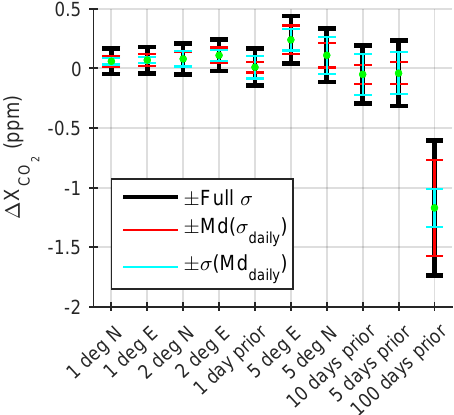
Figure 10. Standard deviations and biases from using wrong model pTz and H 2 O profiles as compared to using the standard option for time and location. Tests are in order of increasing full σ . Red repre- sents intraday variability. Cyan represents interday